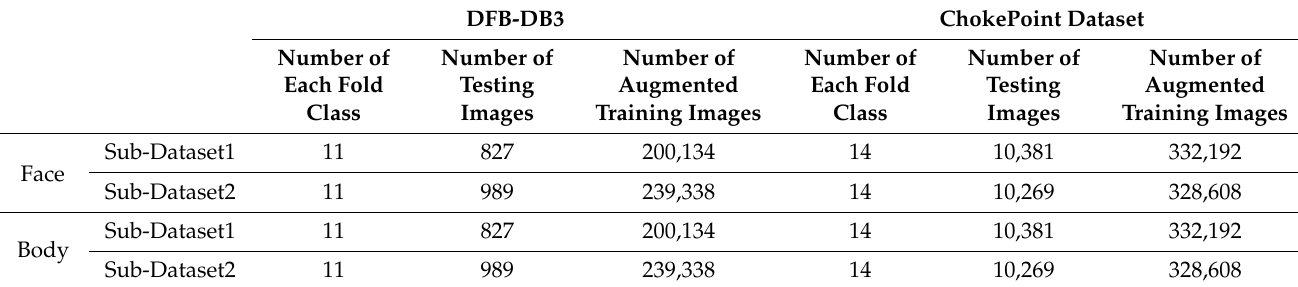
Table 5. Overall images of ChokePoint dataset and DFB-DB3.